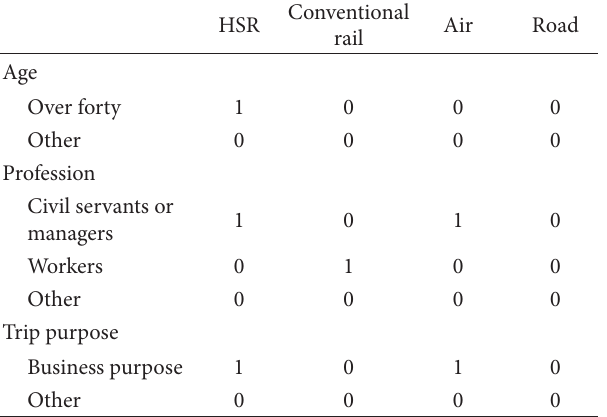
Table 2: Dummy variables used in the utility